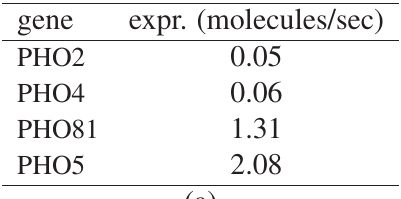
Figure 2: The datasets of the in silico PHO pathway experiment. E phate conditions, while E (b) reflects the high phosphate conditions. The expression levels are q SBP m,hp in terms of molecules per